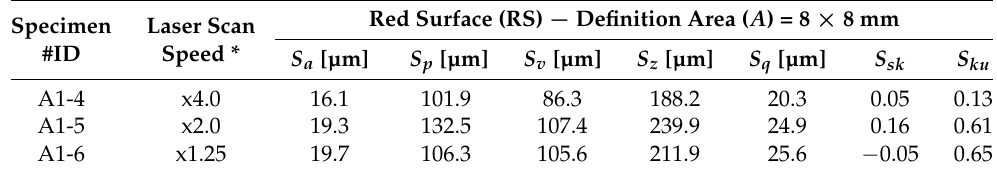
Table 12. Surface texture parameters results increasing the laser scanning speed: red surface ( RS ). Specimen